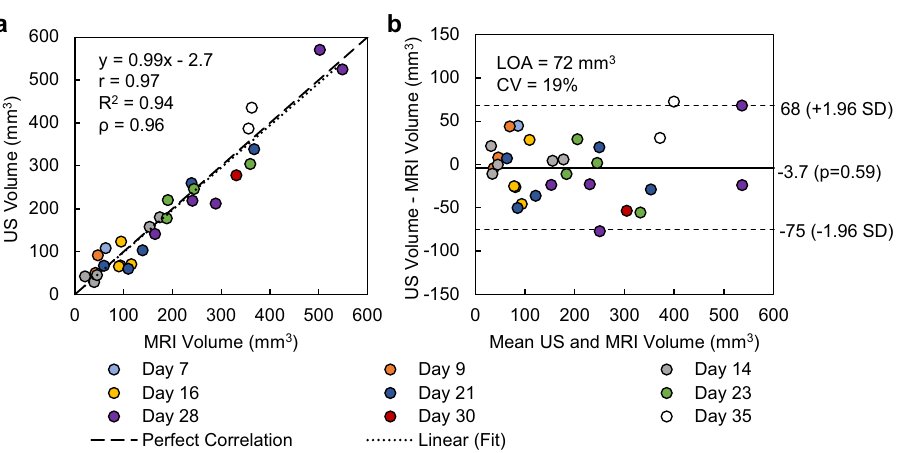
Figure 3. Regression and Bland–Altman plots of US (reader #5) vs MRI volume measurements (reader #6). r –Pearson correlation coefficient, R 2 –coefficient of determination, ρ –Spearman correlation coefficient, CV – coefficient of variation, LOA –limits of